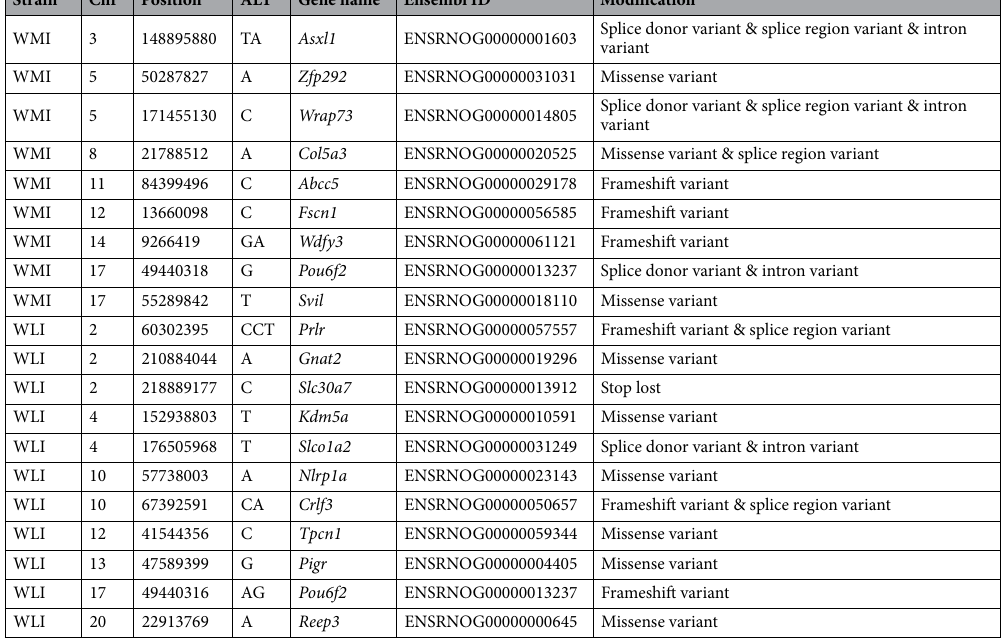
Table S3). Over-represented terms for WMI included Par-3-KIF3A-PKC-zeta complex, actin-mediated cell contraction, neuronal related and cellular stress related pathways (Supplementary Table S3).